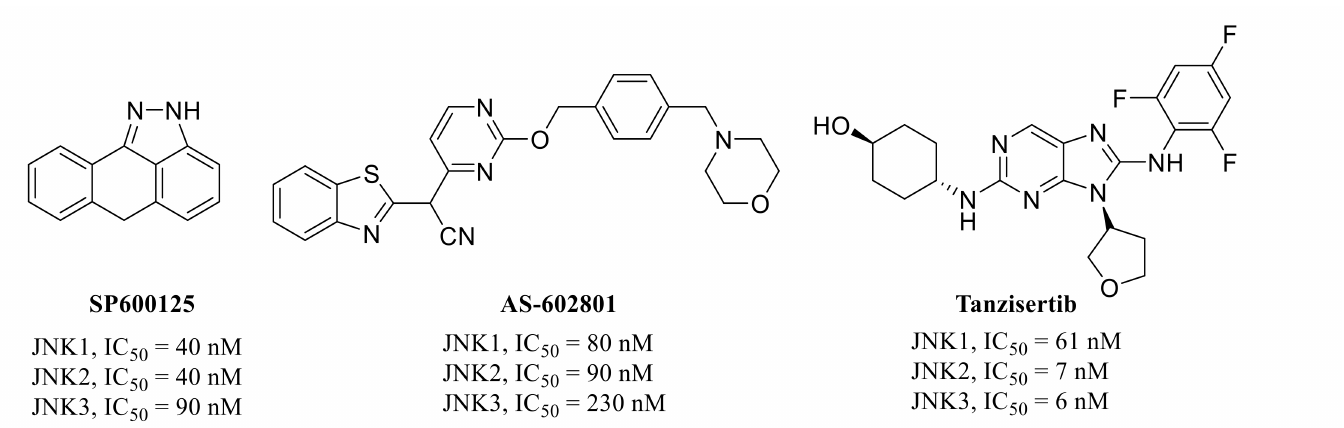
Figure 1. Chemical structures of pan-JNK inhibitors investigated in clinical